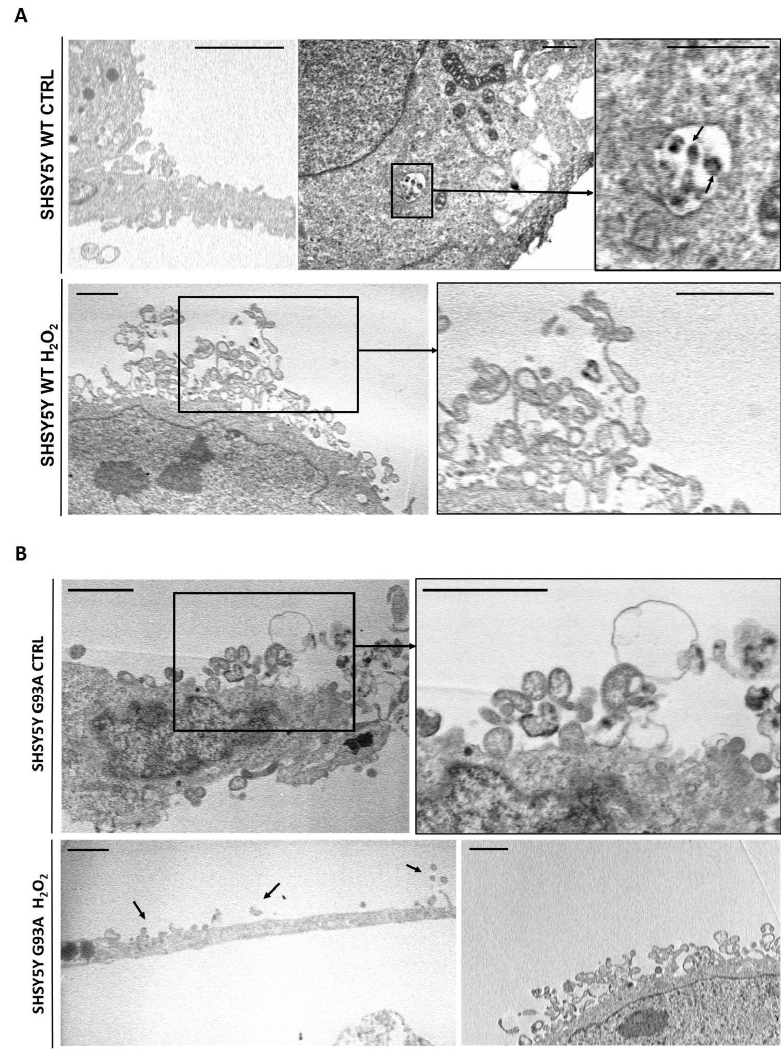
Figure 1. TEM micrographs of ( A ) WT SH-SY5Y cells untreated (control, upper panel) or treated with 100 μ M of H 2 O 2 ( B ) SOD1-G93A SH-SY5Y cells untreated (upper panel) or treated with 100 μ M of H 2 O 2 . Scale bars = 2 μ m. Arrows indicate the details of budding vesicles.